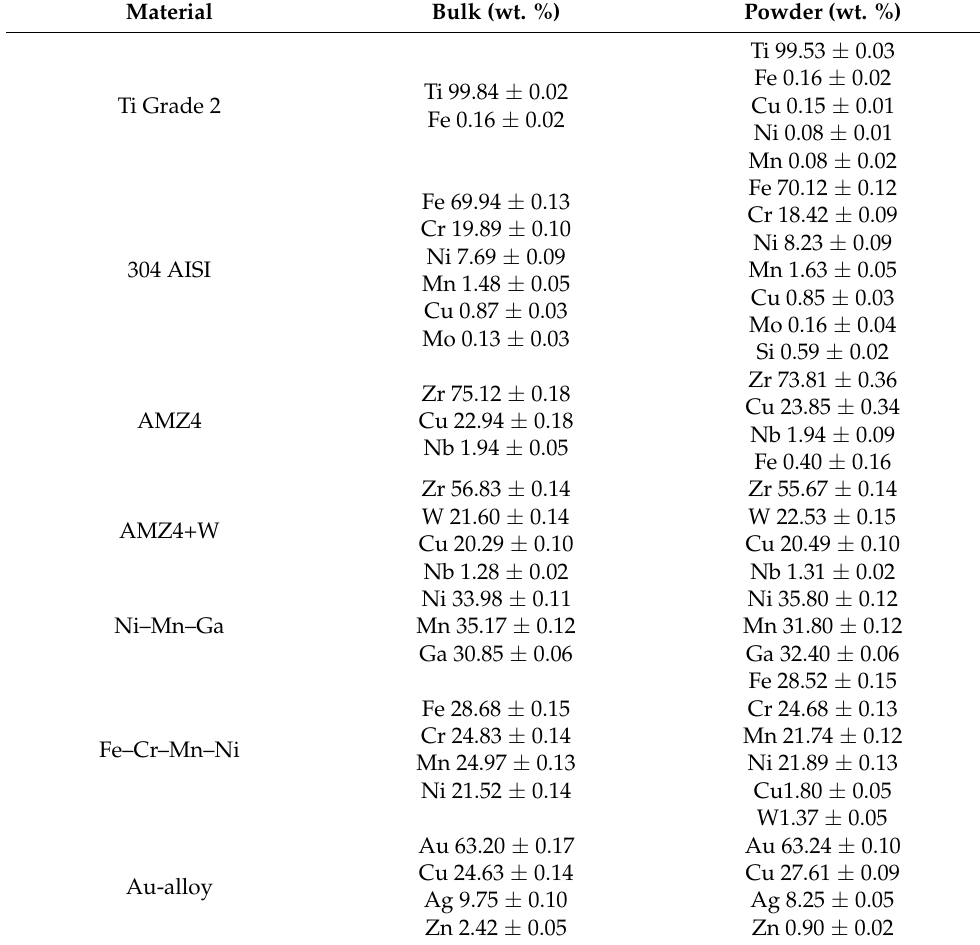
Table 2. Chemical composition of atomized powders measured with